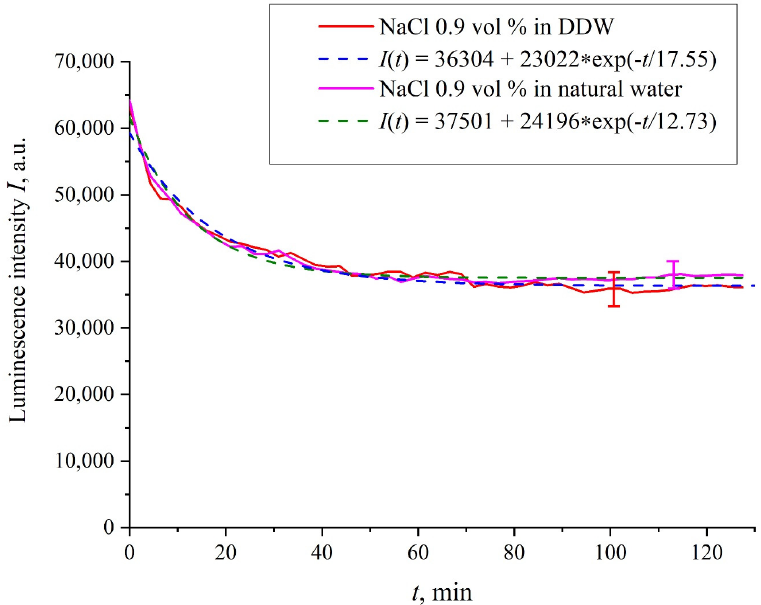
Figure 3. Intensity of luminescence I ( t ) vs. the soaking time in ordinary water-based and DDW-based physiological solutions (0.9 vol.% NaCl) without amino-acids.